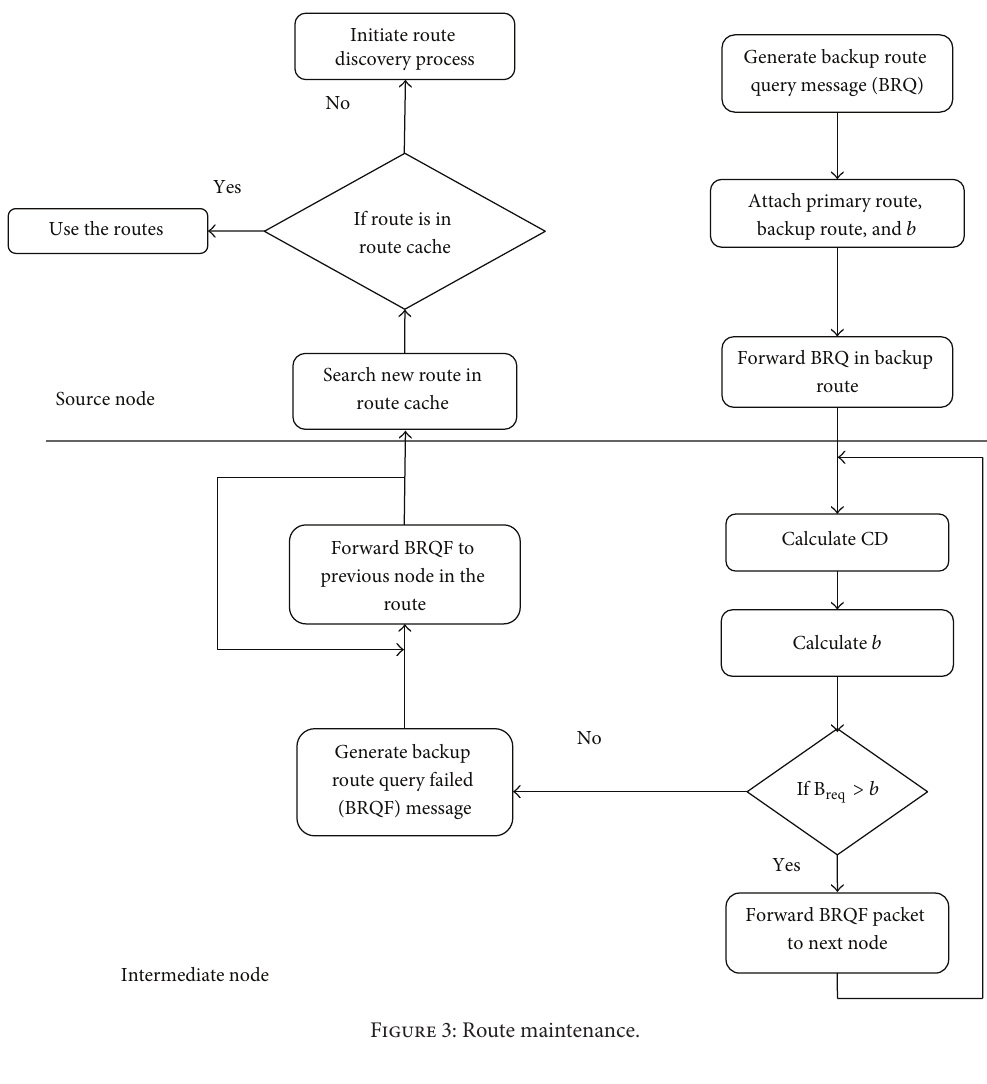
Figure 3: Route maintenance.